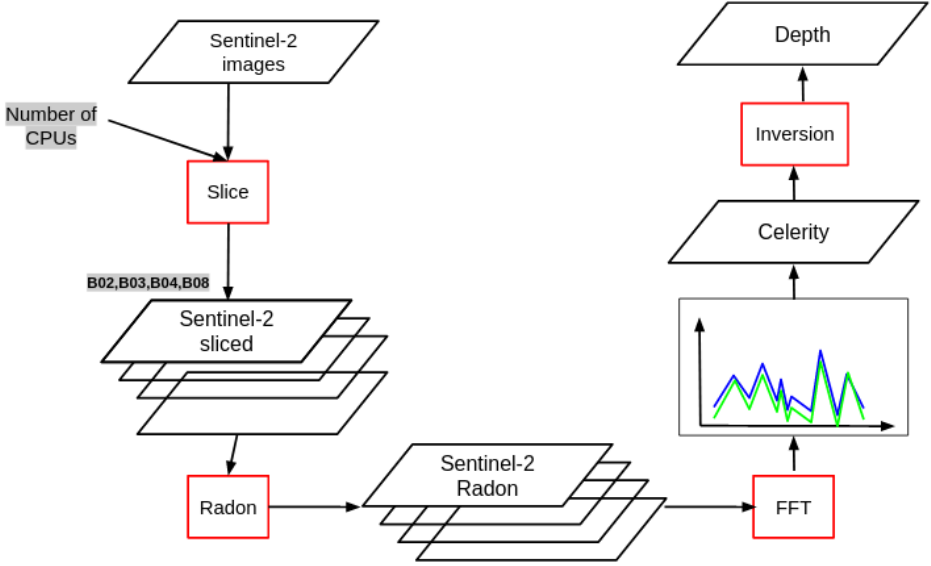
Figure 3. Workflow for Sentinel 2A/B process, from the acquisition to retrieving the